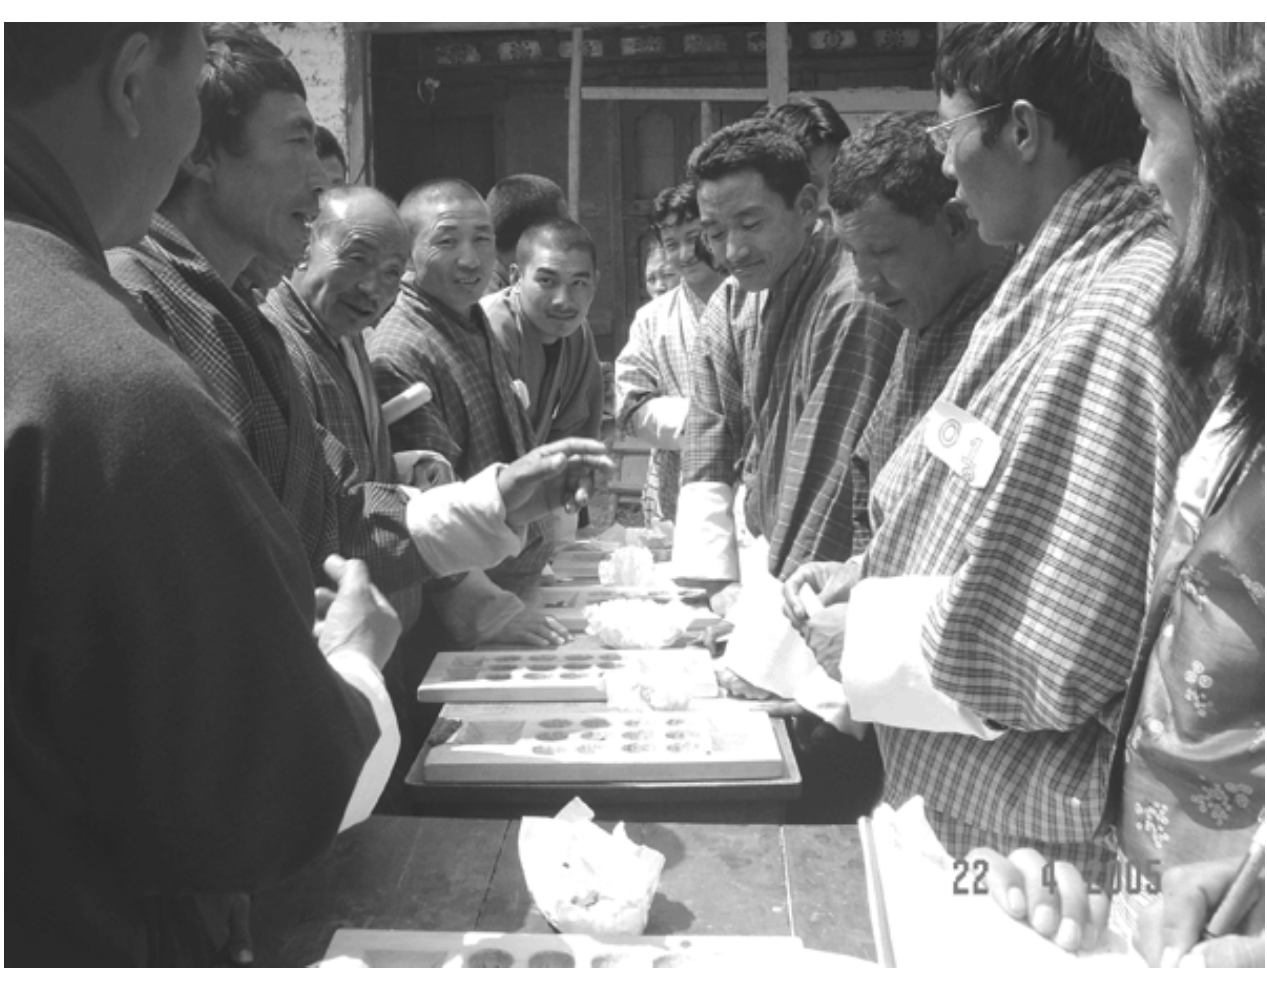
Fig. 9. Third RPG in